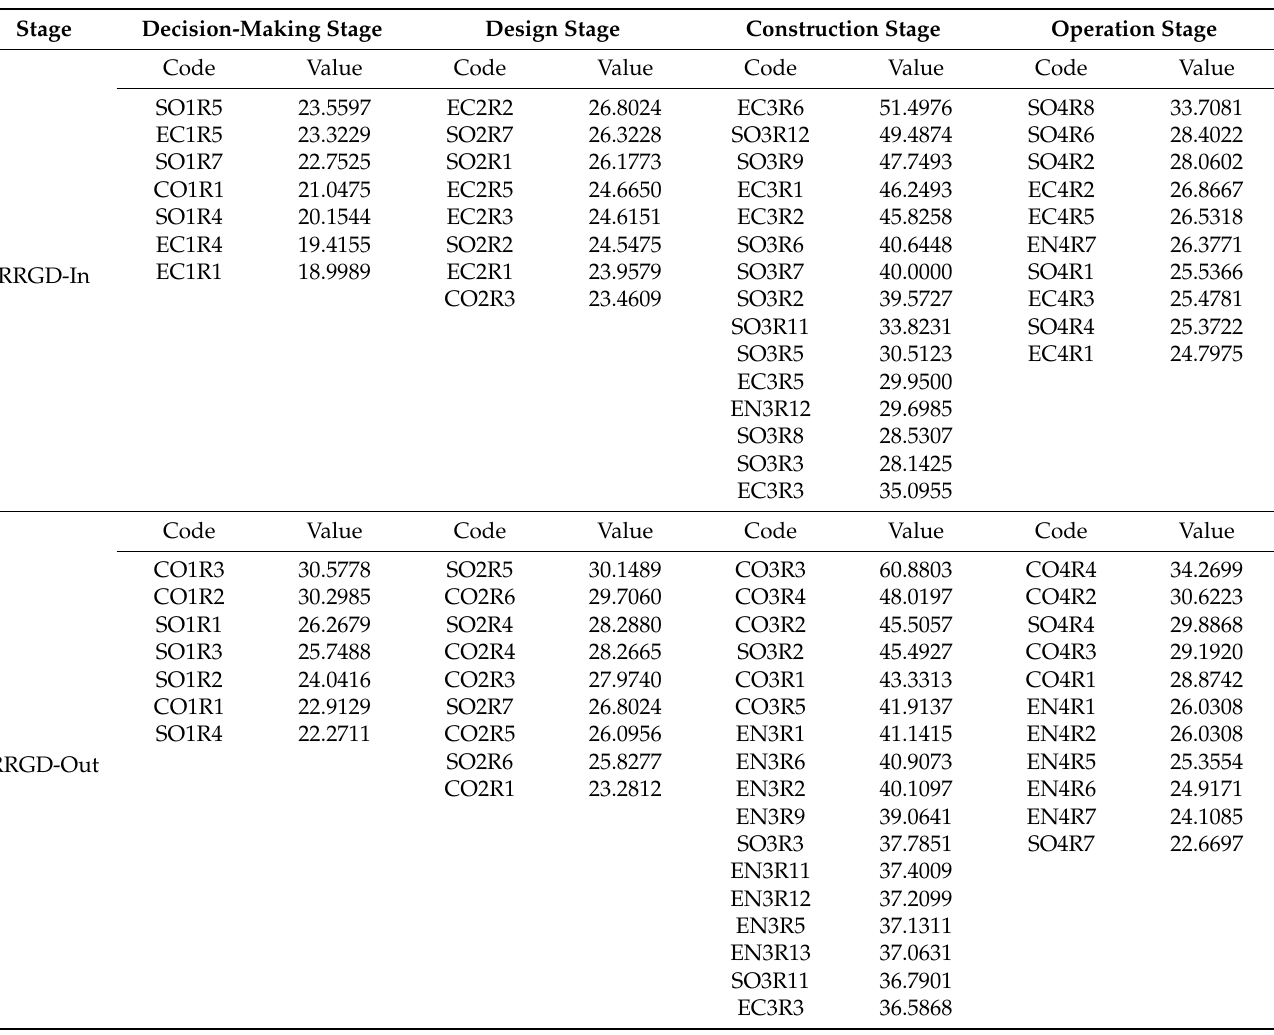
Table 5. RRGD-In and RRGD-Out key